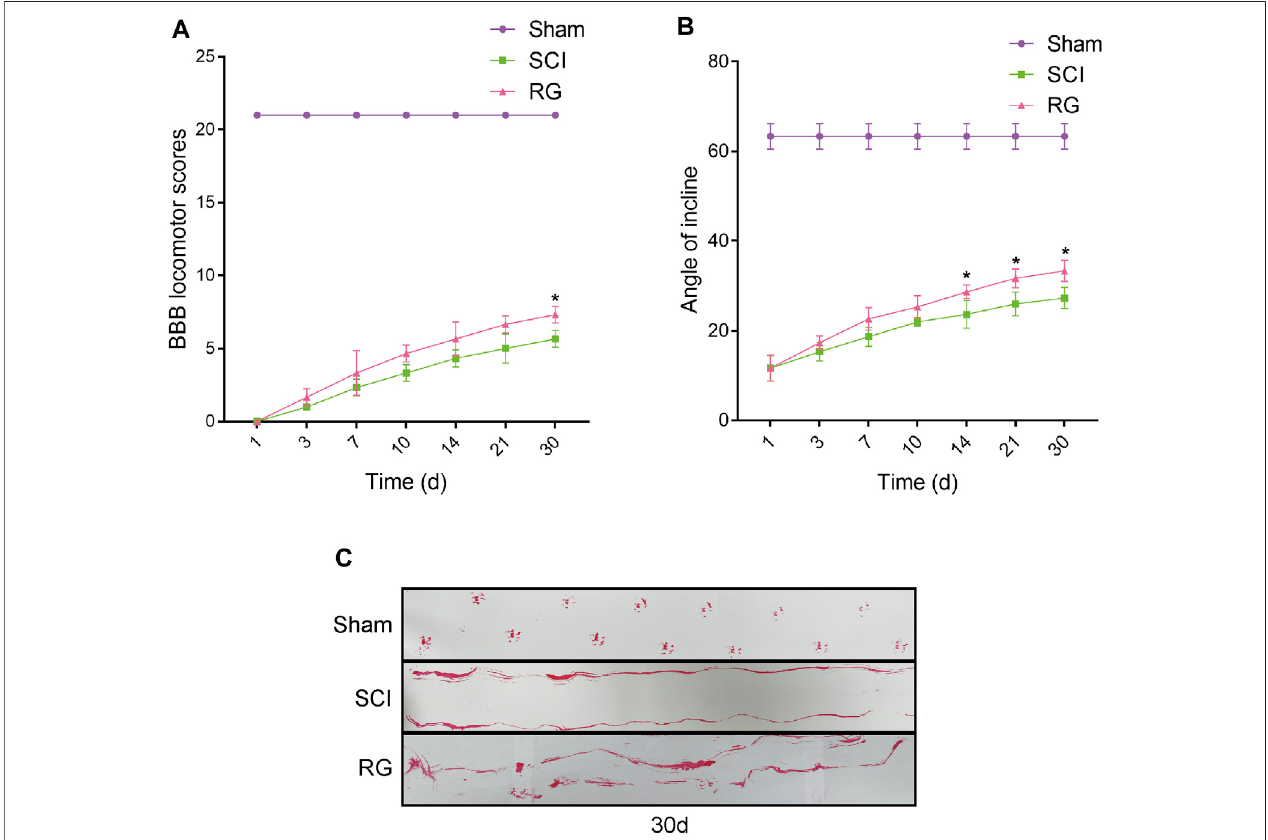
FIGURE1| RGcanslightlypromoterecoveryfromSCIinrats. (A) TheBBBscoresoftheratsintheSham,SCI,andRGgroups. (B) Theinclinedplanetestscoresof rats in the Sham, SCI, and RG groups. (C) Gait imprint analysis. A two-way analysis of variance (ANOVA) test was used to analyze BBB scores and inclined plane test scores, and then Dunnett ’ s post hoc test was used. “ * ” represents p < 0.05 versus the SCI group with statistical signi fi cance. Data are represented as mean ± SD ( n = 3).